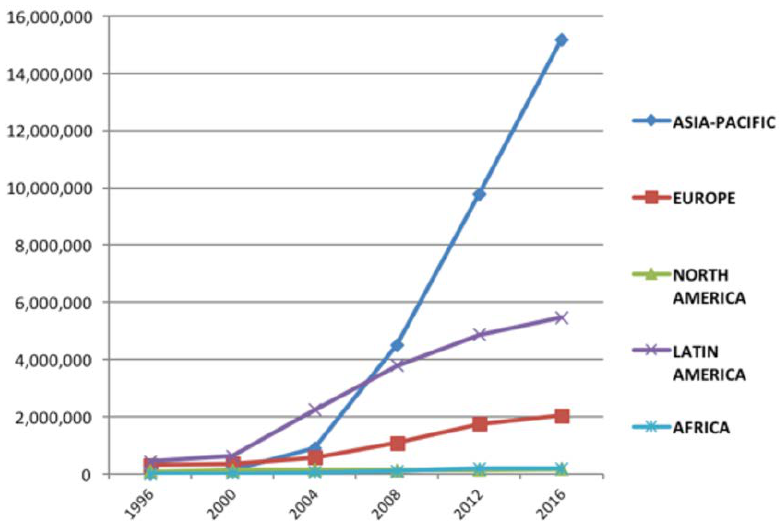
Figure 4. Natural-gas vehicles by region from 1996 to 2016 [78]. Table 4. Top 10 countries by natural-gas vehicle (NGV) population [78].